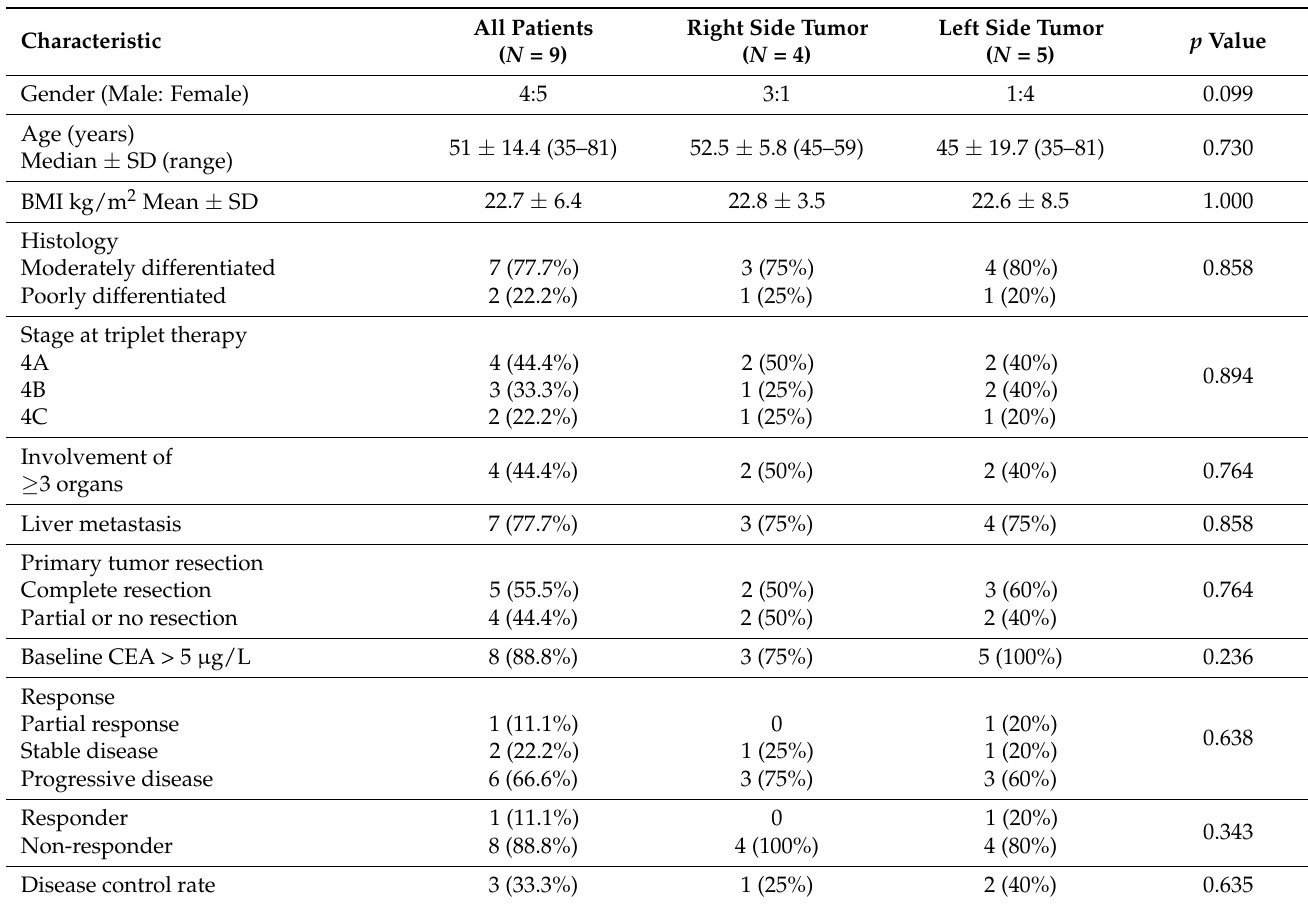
Table 1. Baseline characteristics of all included patients with BRAF -mutated mCRC receiving triplet therapy, stratified by tumor